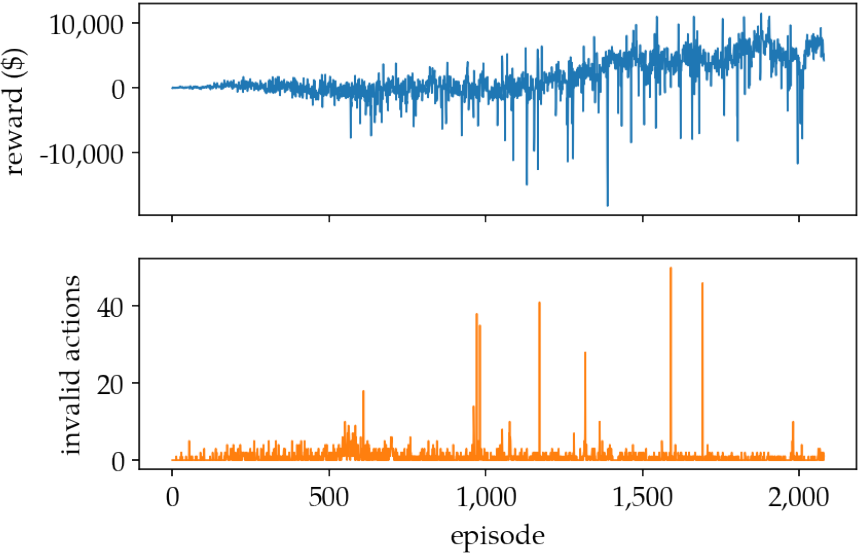
Figure 17. Training curves of the proposed model (three-day episode duration).